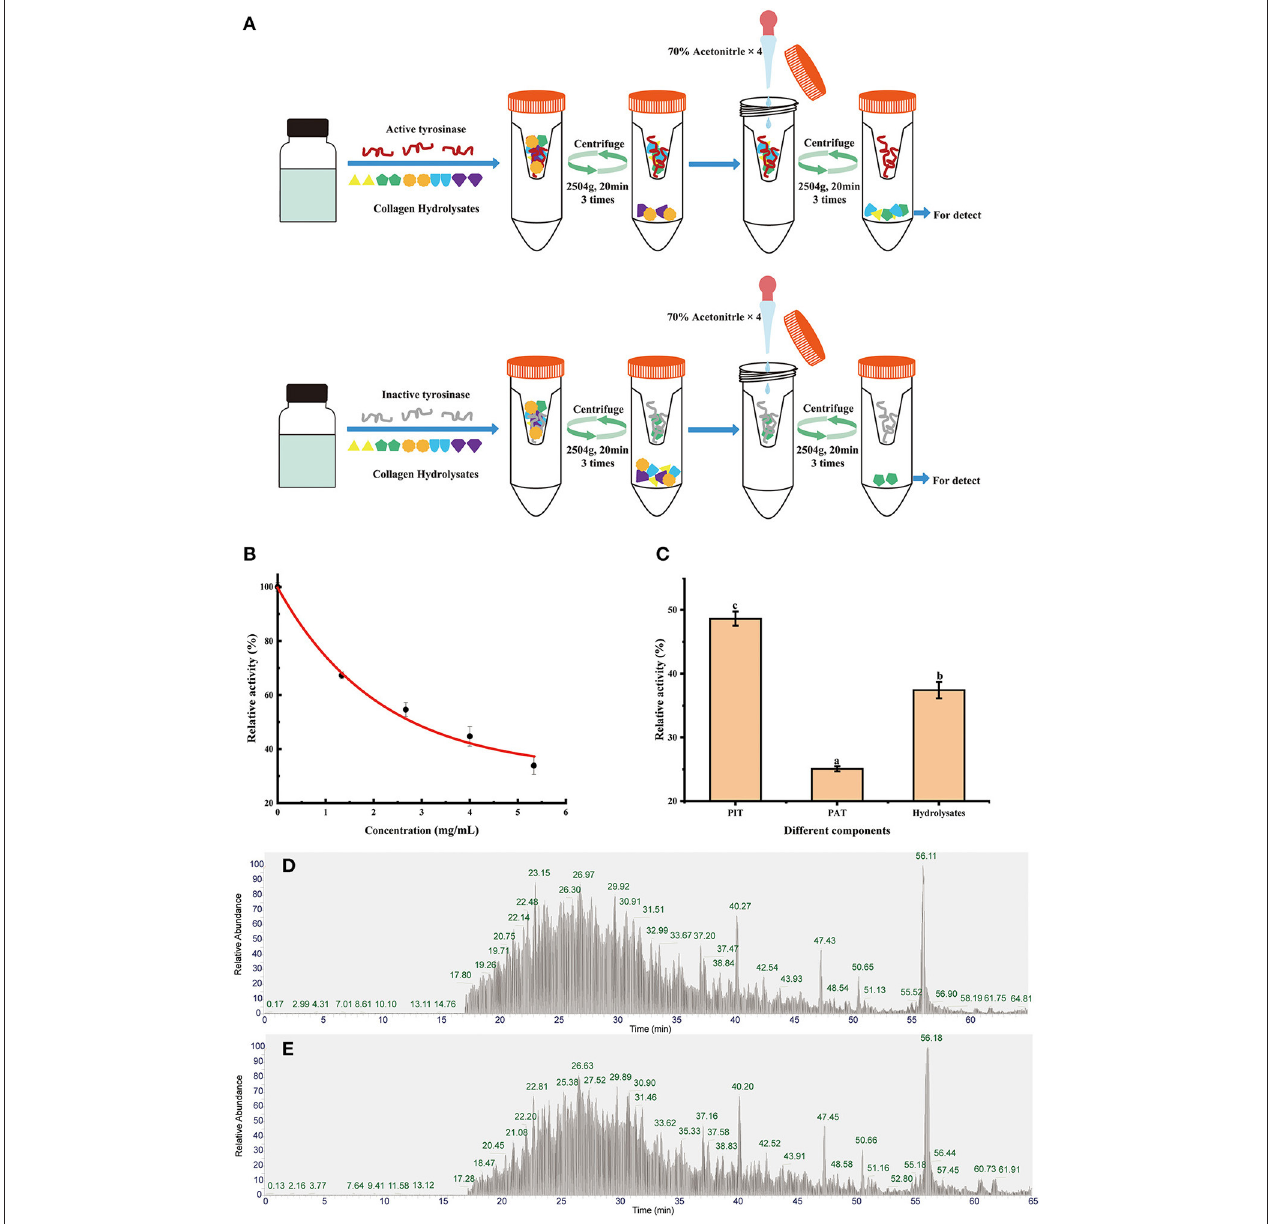
FIGURE 2 | Diagrams of biological affinity ultrafiltration—liquid mass spectrometry screening methods (A) , the tyrosinase activity of hydrolysates (B) , ultrafiltration fractions (C) , the total ion chromatography (TIC) of PAT (D) , and PIT (E) . Different lowercase letters represent significant differences between different groups ( p <